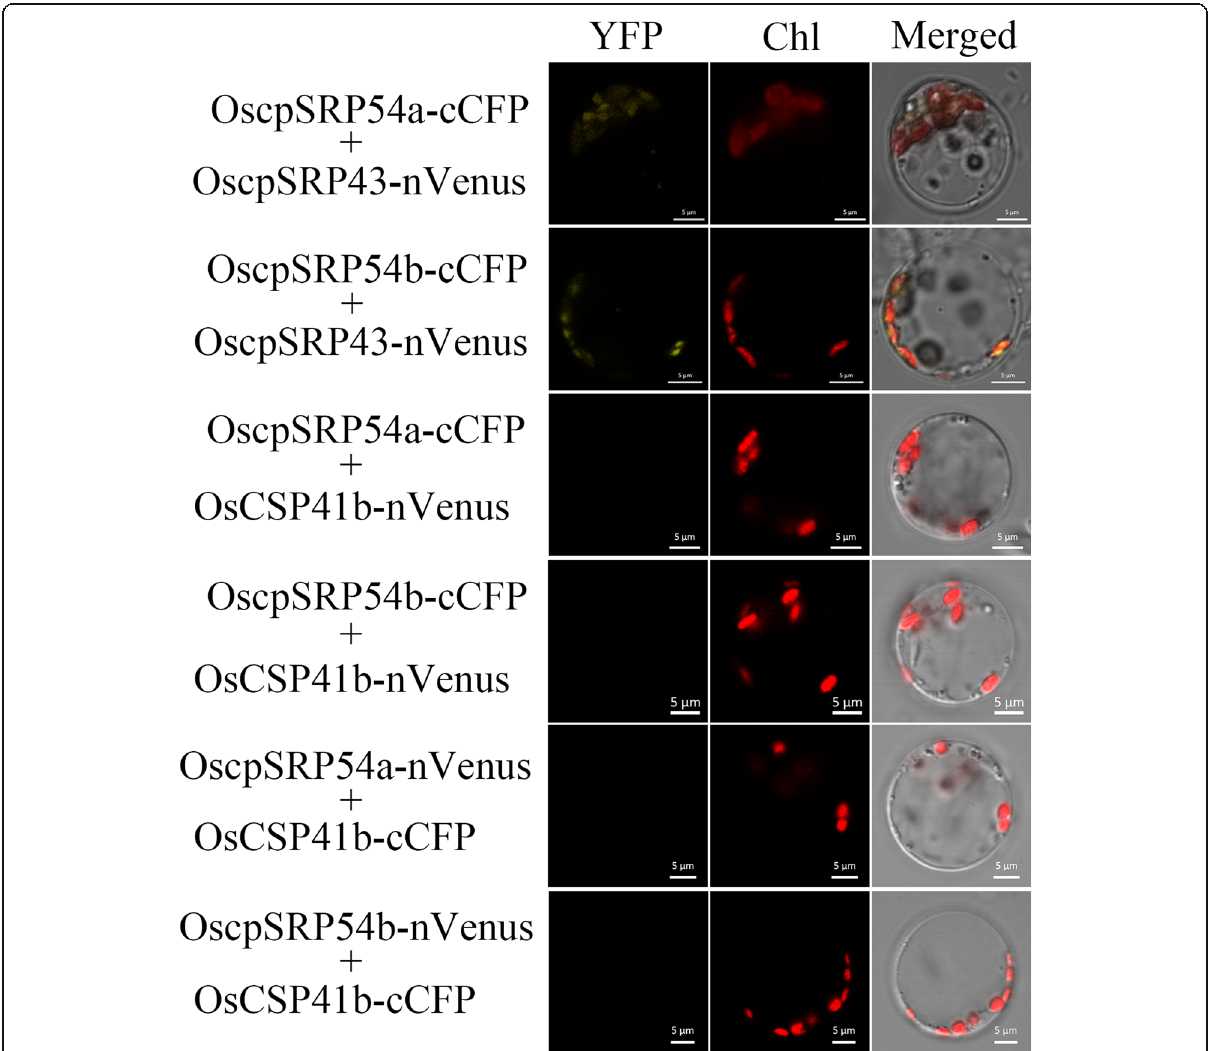
Fig. 9 BiFC assay for interaction between OscpSRP54a, OscpSRP54b and OscpSRP43 in rice protoplasts. Green fluorescence indicates GFP signal, red fluorescence indicates chloroplast autofluorescence, and yellow fluorescence indicates the merged signal of green and red